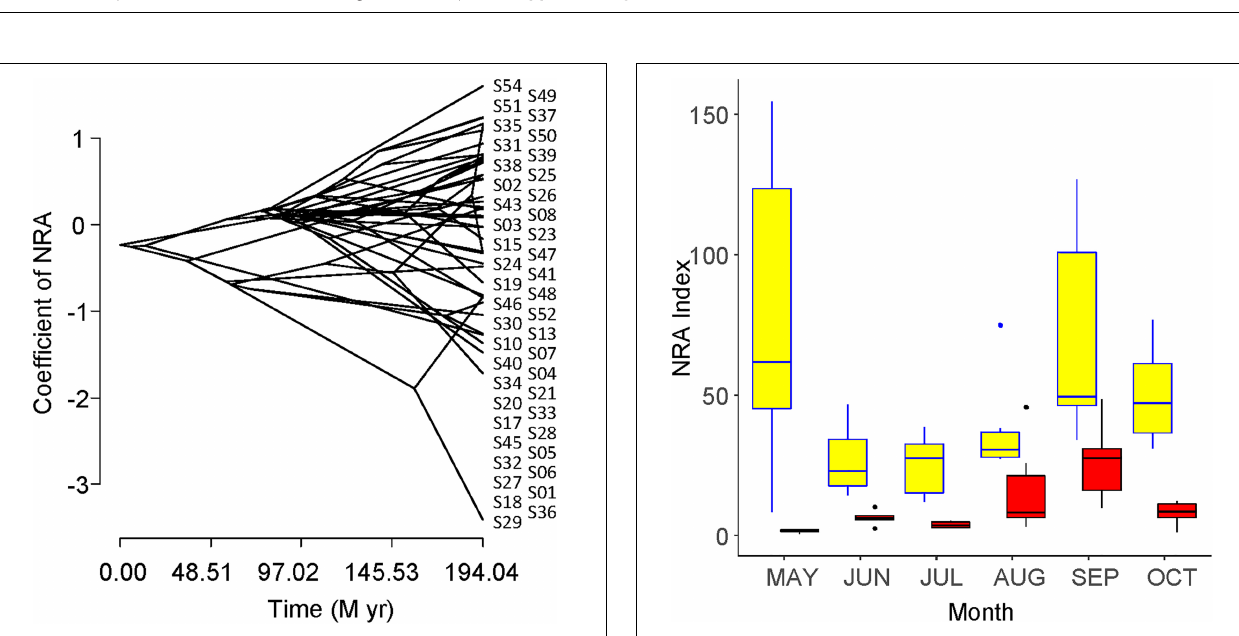
Frontiers in Ecology and Evolution |